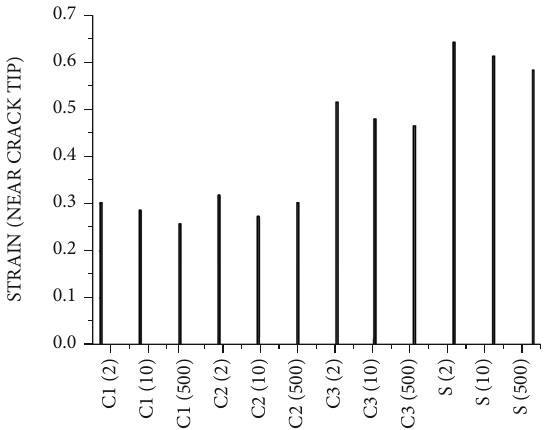
Figure 9: Maximum strain at the crack tip.